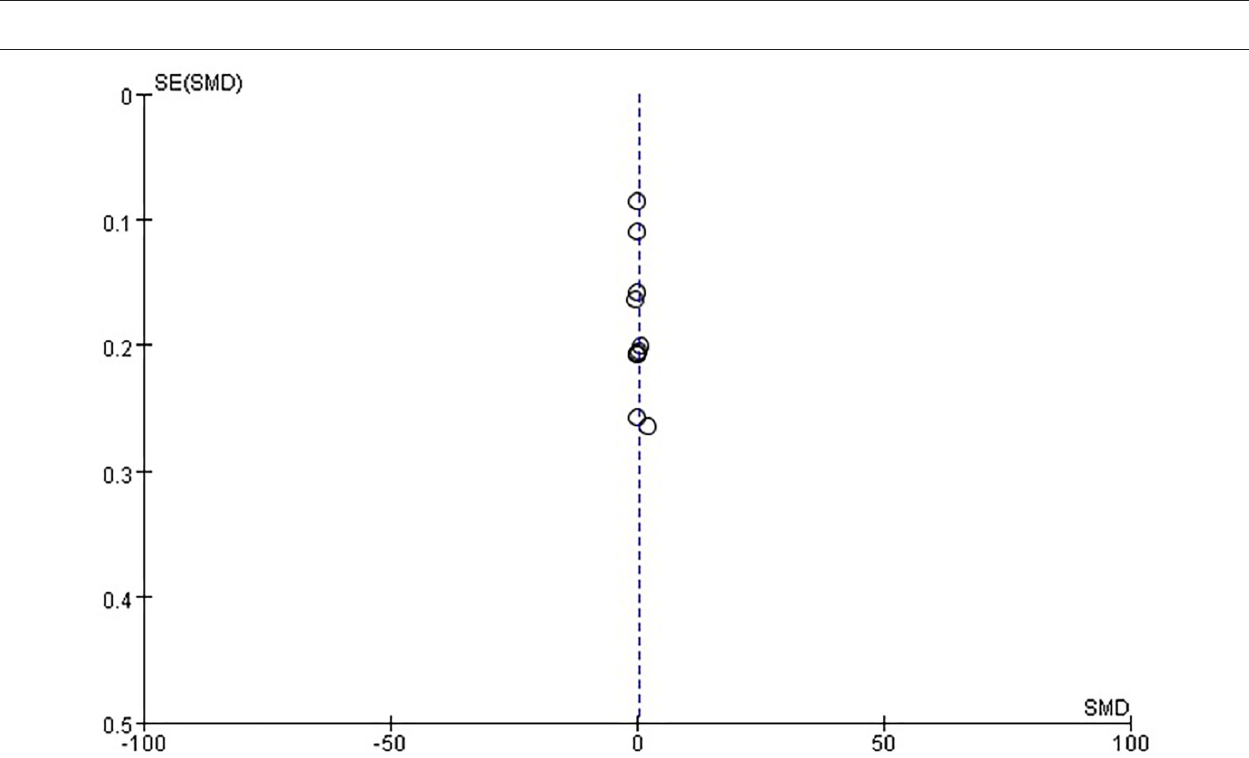
FIGURE 9 | Funnel plot of comparison: ESD care vs. usual care, outcome: activities of daily living (ADL).